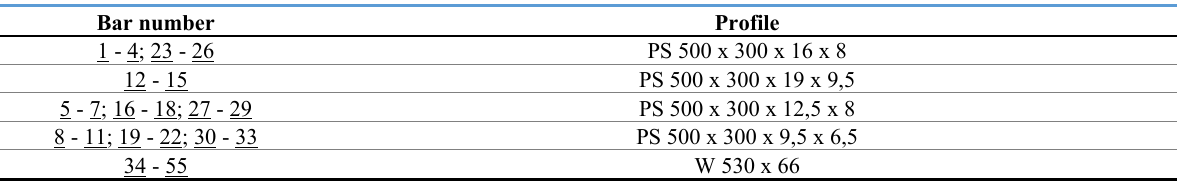
Table 2 – Profiles used for columns and beams (dimensions in mm). Source: Authors (2020) Bar number